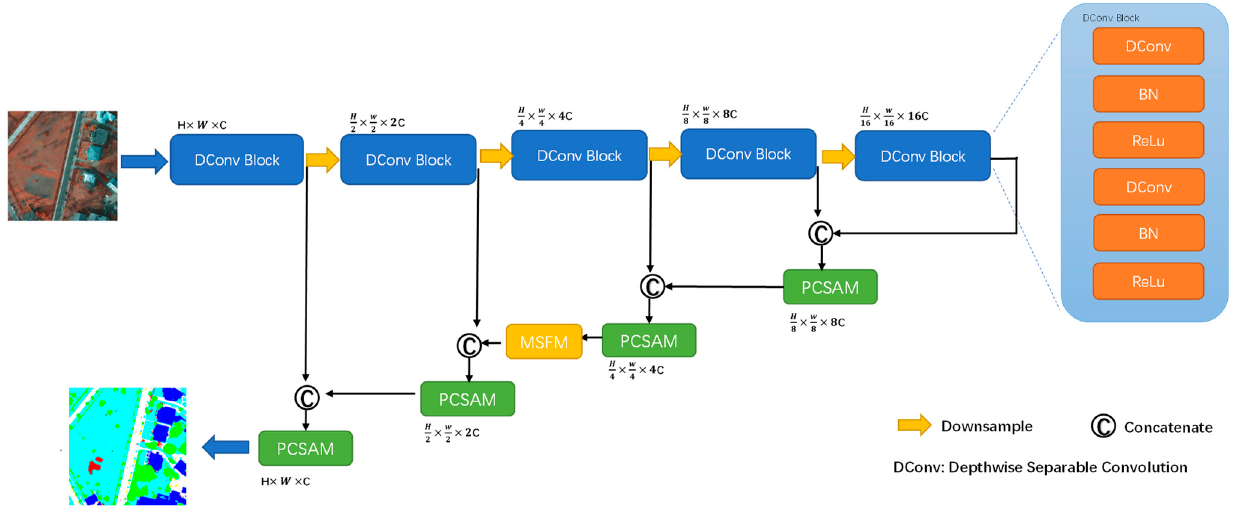
Figure 2. The architecture of